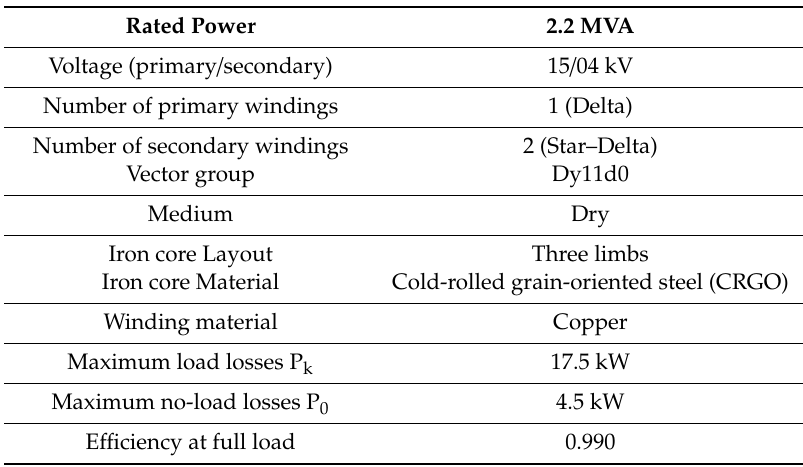
Table 2. Main parameters of the standard transformer